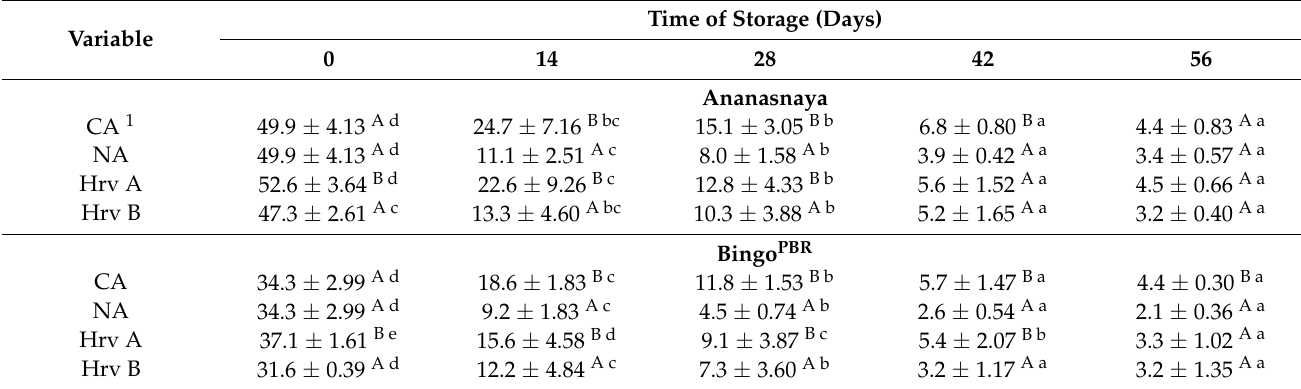
Time of Storage